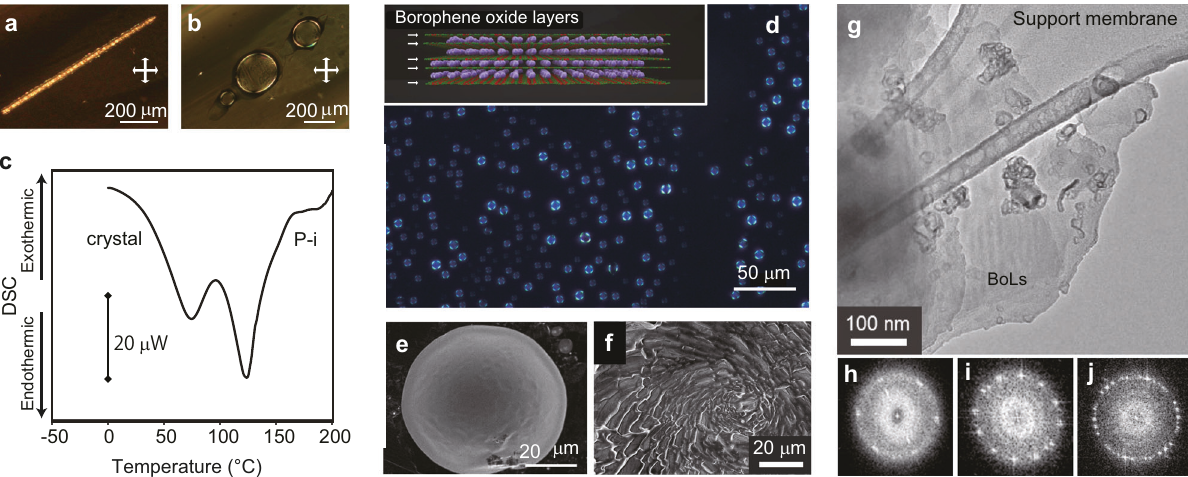
Fig. 1 Change from the crystal phase to the layered liquid phase. Polarized optical microscopy images of a crystal of borophene oxide layers (BoL-C) ( a ) and liquid crystals of borophene oxide layers (BoL-LC) ( b ) under crossed polarizers (white double arrows). c Differential scanning calorimetry (DSC) heating curve corresponding to the change from the crystal to BoL-LC phase (P-i) in a glass capillary. d Optical microscopic image of BoL-LC droplets. The image was obtained under crossed polarizers with a sensitive tint plate. The inset of d shows a chemical structure of the prepared BoLs. White arrows indicate the borophene oxide atomic layers. The purple spheres represent potassium cations. e A scanning electron microscope (SEM) image for a drop of BoL-LC. f Close-up of the central position of the liquid crystal after solidi fi cation by air oxidation process. g A transmission electron microscope (TEM) image of BoL-LC on a microgrid. h – j Electron beam diffraction patterns correspond to single, double, and several layers, respectively.